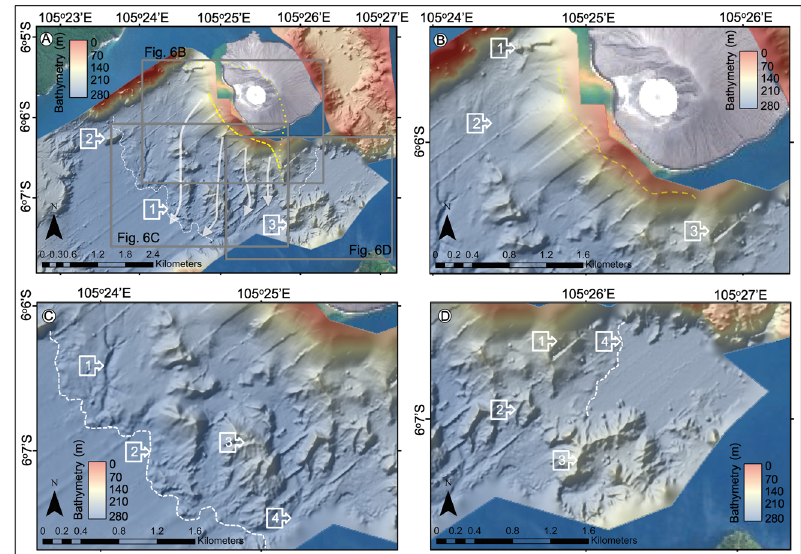
Fig. 6 Post-collapse bathymetry of the sea fl oor surrounding Anak Krakatau collected in August 2019. A Bathymetry of the SW and NE fl anks of Anak Krakatau showing the clear evidence of a large landslide deposit in the caldera basin adjacent to the SW fl ank and no landslide materials in the shallow- water NE basin. B Magni fi ed image of the bathymetry of the SW slope of Anak Krakatau transitioning into the landslide debris and blocks. C Magni fi ed image of the bathymetry of the 2018 landslide blocks in the caldera basin adjacent to the SW fl ank of Anak Krakatau. D Magni fi ed image of the bathymetry of the older identi fi ed landslide blocks immediately south of Anak Krakatau, which show greater degradation and gullying from exposure to submarine currents.